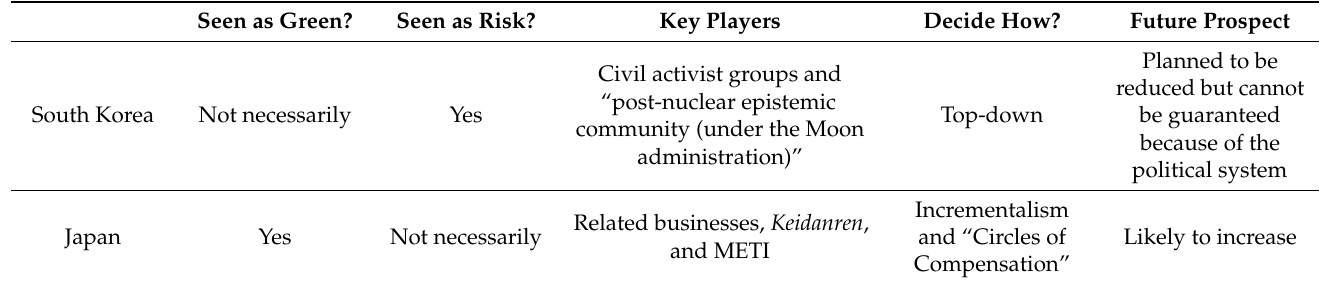
Table 2. Comparison on Nuclear Power’s Position in South Korea and Japan. Seen as Green? Seen as Risk? Key Players Decide How? Future Prospect Civil activist groups South Korea Not necessarily Yes